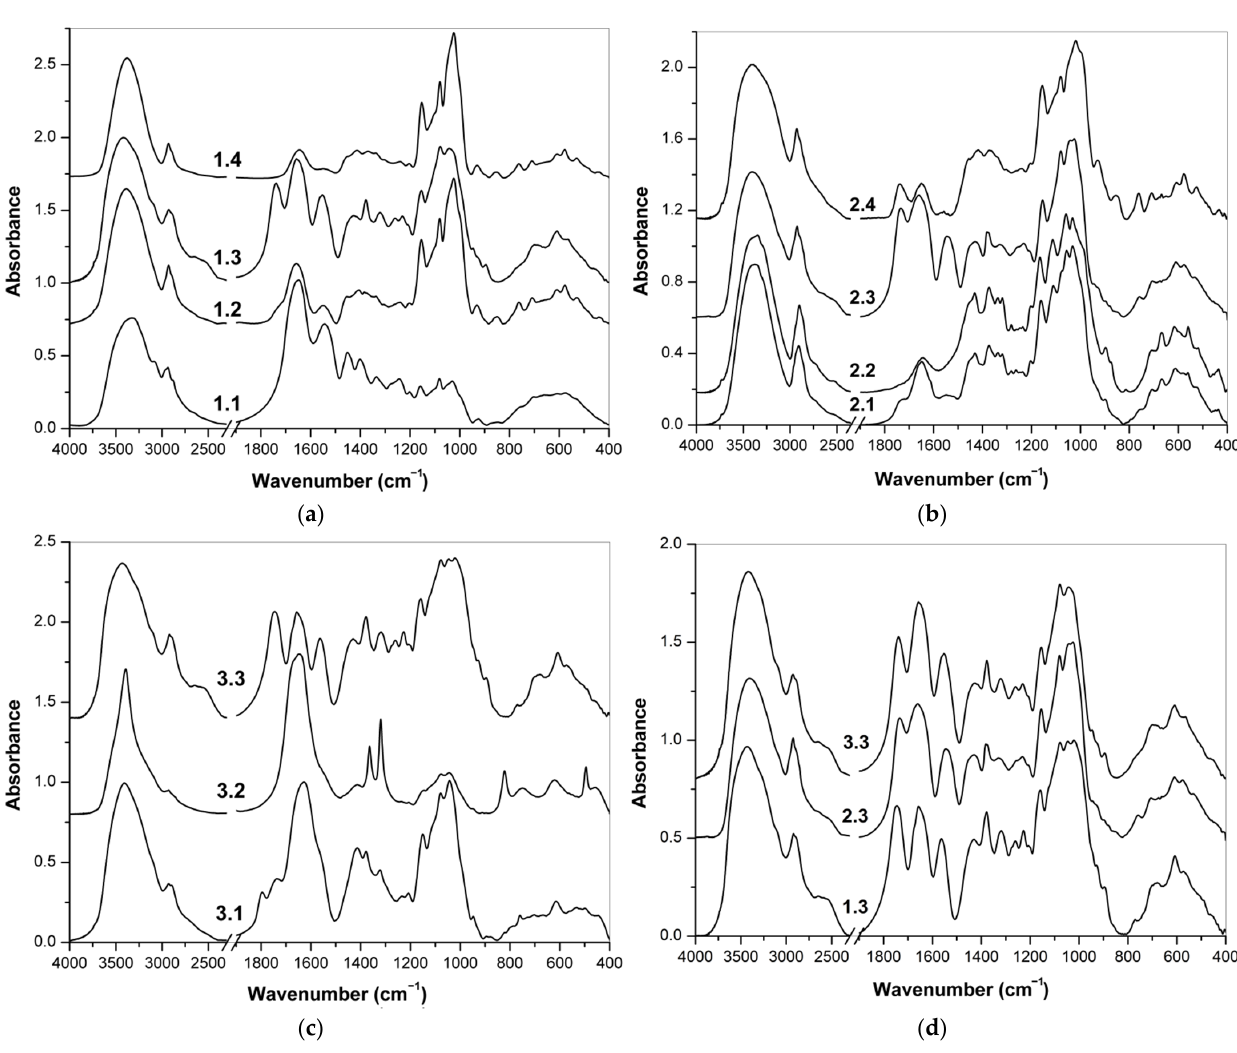
Figure 5. FT-IR spectra of the fractions obtained from: ( a ) supplement 1; ( b ) supplement 2; ( c ) supplement 3; ( d ) FT-IR spectra of the fractions 1.3, 2.3 and 3.3 with an expected high content of hyaluronic acid obtained from supplements 1, 2 and 3, respectively.